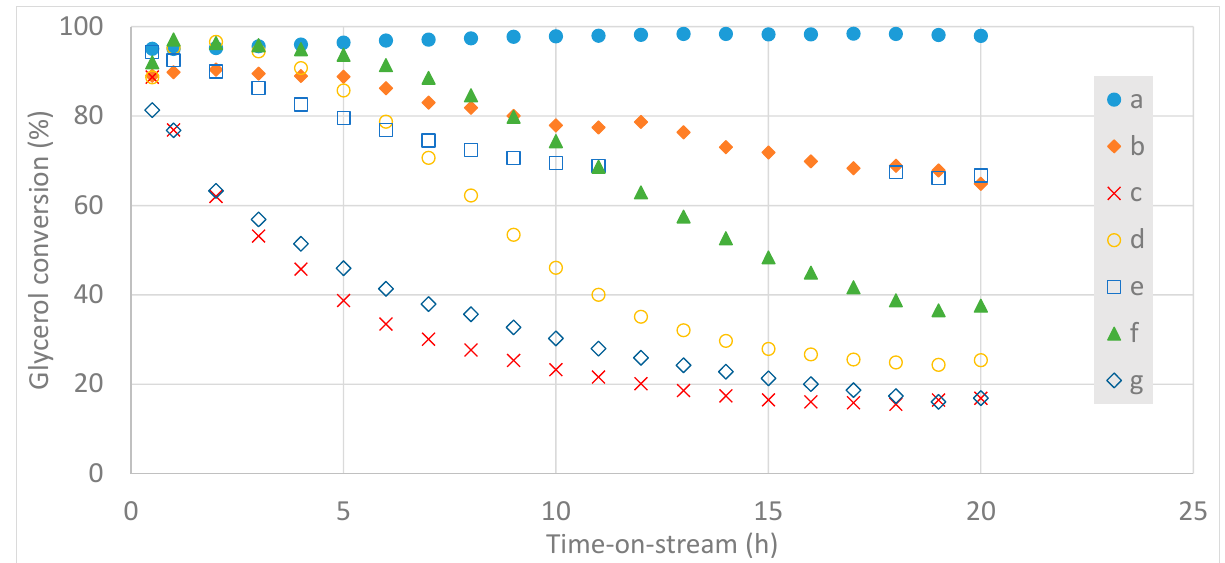
Figure 6. Glycerol conversion at 650 °C, feed 10 wt% glycerol in water: ( a ) La 0.3 Zr 0.7 NiO 3 ; ( b ) 10 wt% Ni/(0.3La 2 O 3 –0.7ZrO 2 ); ( c ) La 0.8 Sr 0.2 NiO 3 ; ( d ) CeNiO 3 ; ( e ) La 0.3 Ce 0.7 NiO 3 ; ( f ) 10 wt% Ni/(0.3La 2 O 3 -0.7CeO 2 ); ( g ) LaNiO 3 .